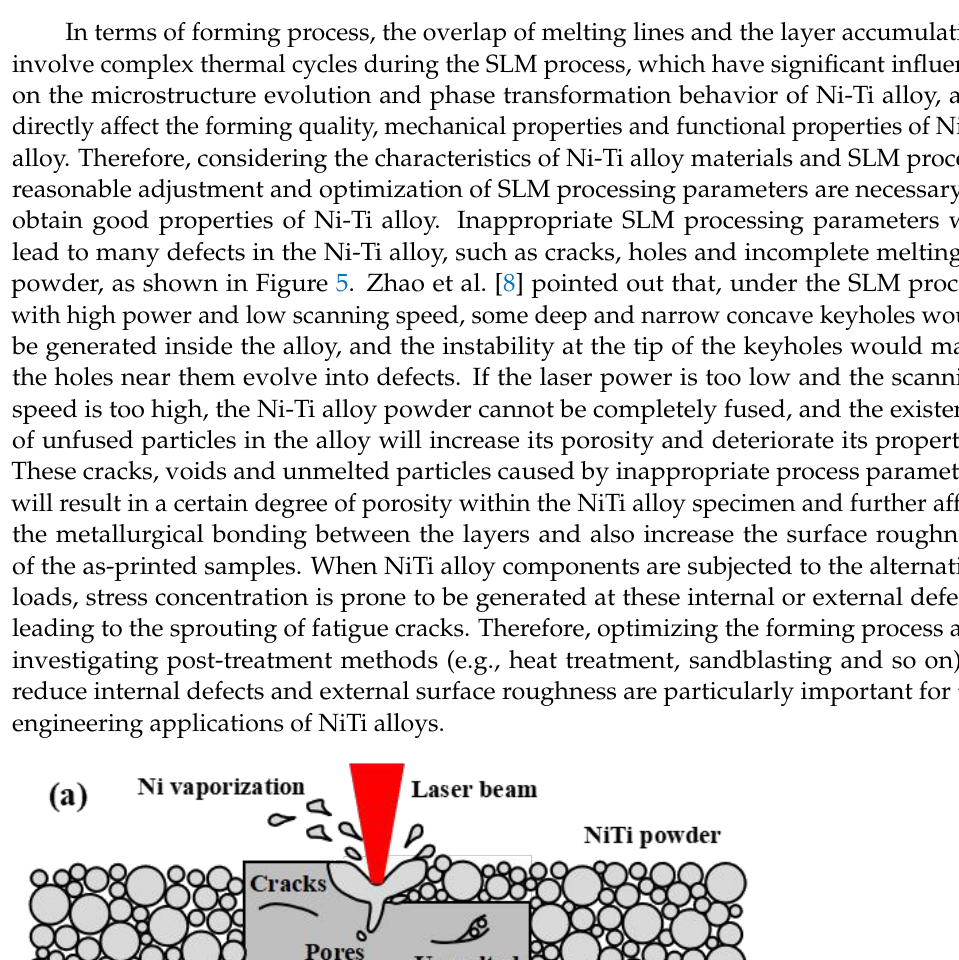
Figure 6. Grain morphology of Ni-Ti alloys formed by SLM parallel to and perpendicular to the depositing direction: ( a , b ) OM; ( c , d ) EBSD; ( e , f ) SEM [9–12]. The phase transition temperature of Ni-Ti alloy is closely related to the Ni/Ti atomic ratio [2]. Therefore, the ablation and evaporation degree of nickel element in the Ni-Ti alloy can be controlled by adjusting the SLM processing parameters, so as to realize the precise control of phase transition temperature. Mathew et al. [14] and Yang et al. [11]